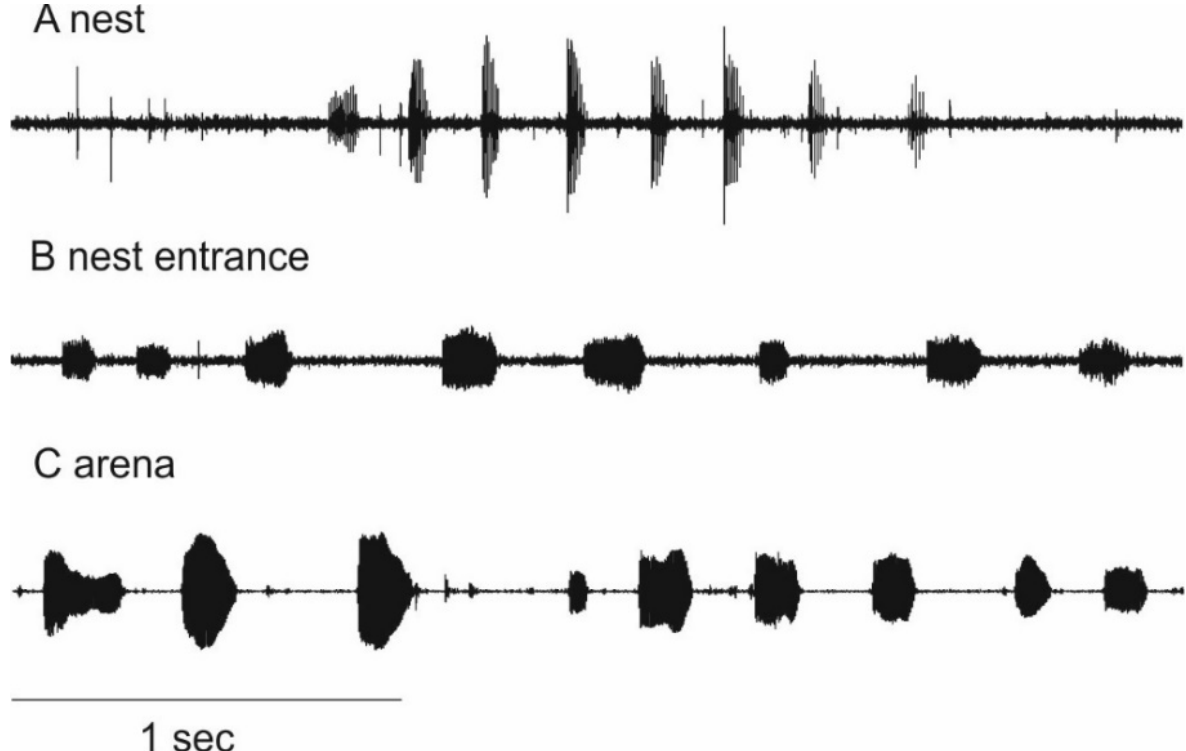
Figure 2. Vibrational pulse trains produced by A. ferruginea at different measurement points (bandpass filter 0.1–3 kHz) where ( A ) is Foraging vibrations produced inside of the nest, ( B ) is Guarding vibrations produced in the entrance tube, and ( C ) is Guarding vibrations produced in an